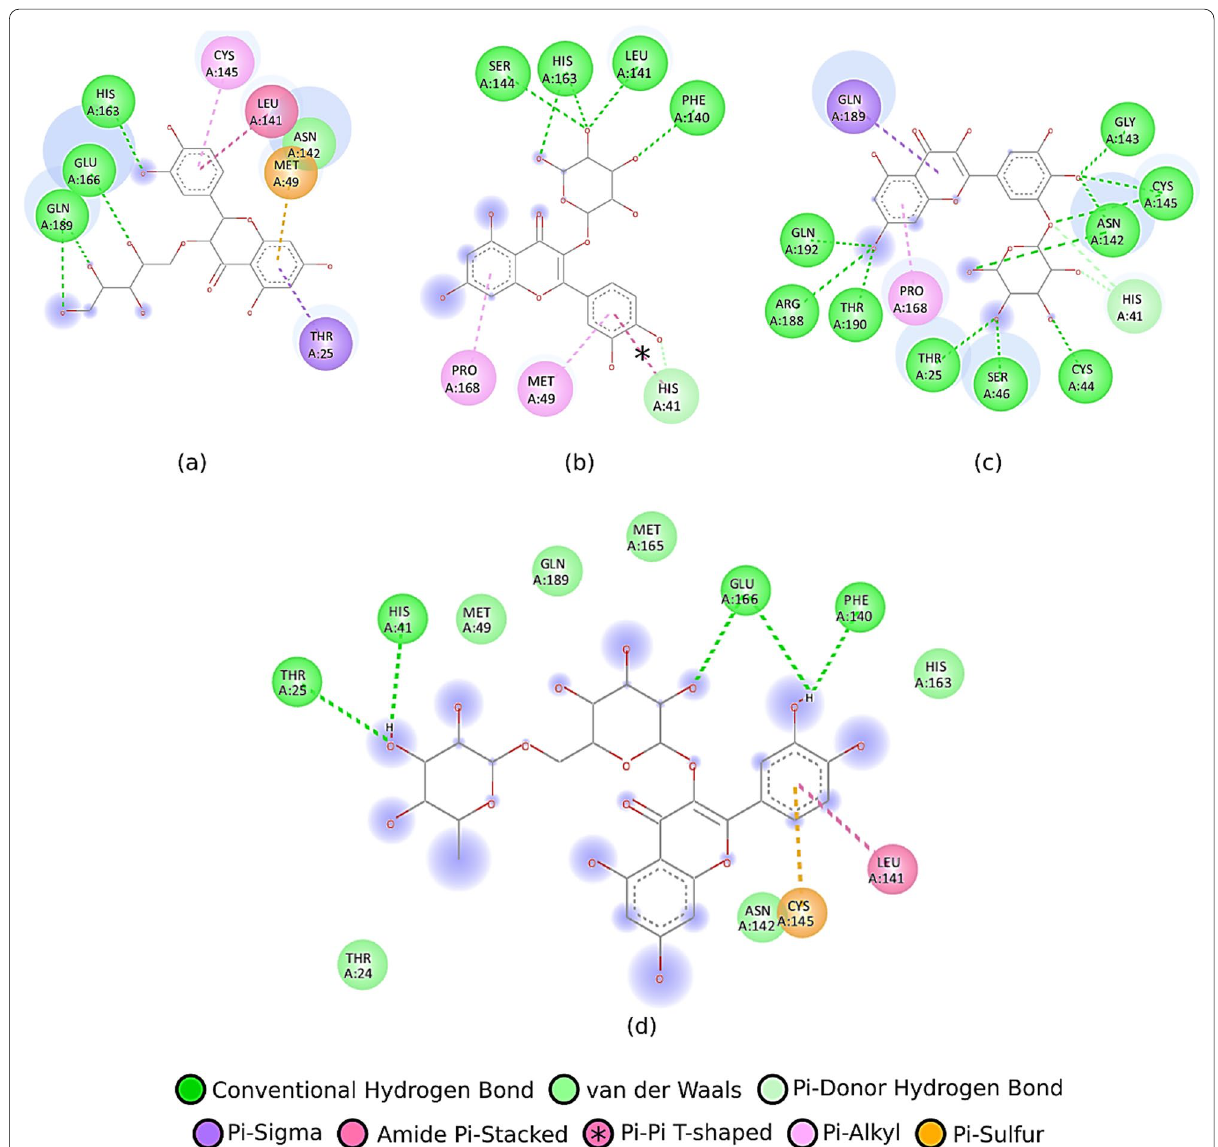
Fig. 2 Ligand–protein interactions of a taxifolin 3-O-α-arabinopyranose, b quercetin 3-O-glucose, c quercetin 3 ′ -glucoside, and d